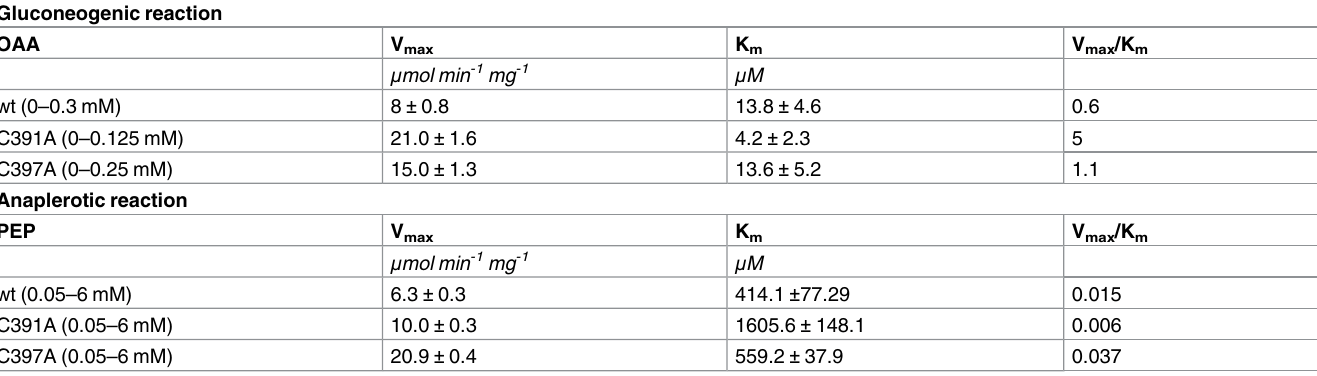
Table 3. Kinetic values of wt and Pck cysteine mutants. Gluconeogenic